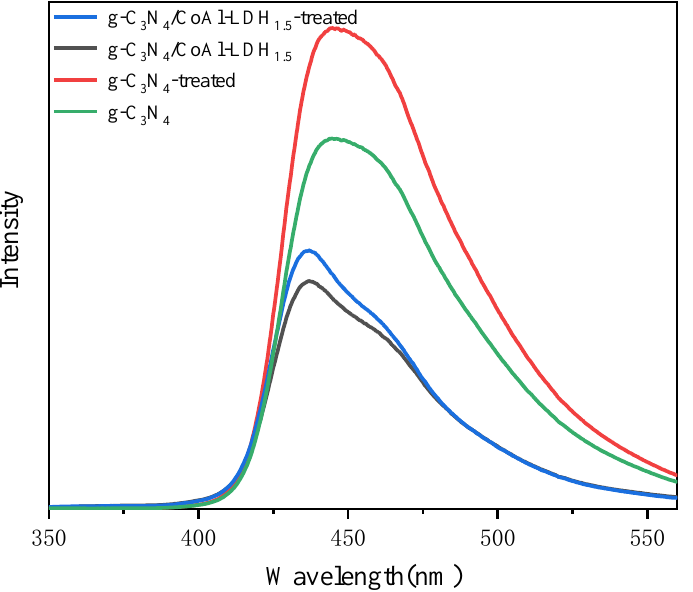
Figure 9. PL spectra of g-C 3 N 4 and the g-C 3 N 4 /CoAl-LDH 1.5 nanocomposite before and after immersing treatment by simulated concrete pore solution.